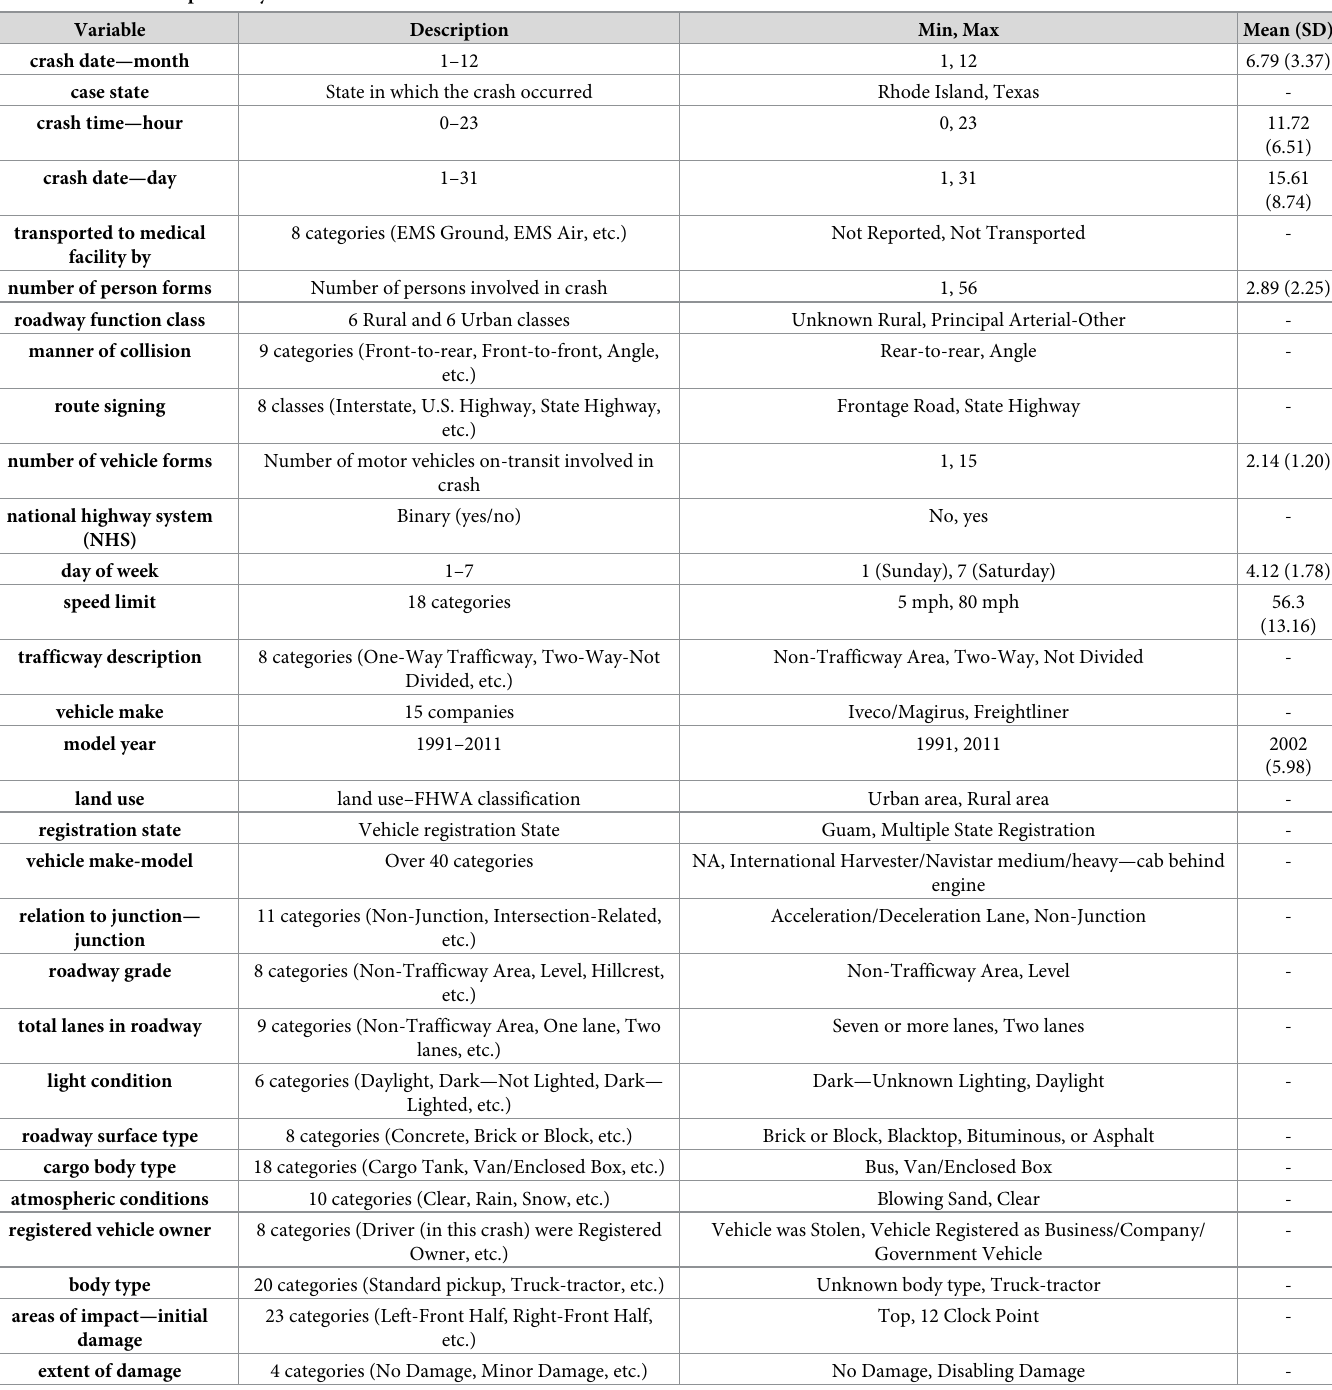
Table 2. The selected explanatory